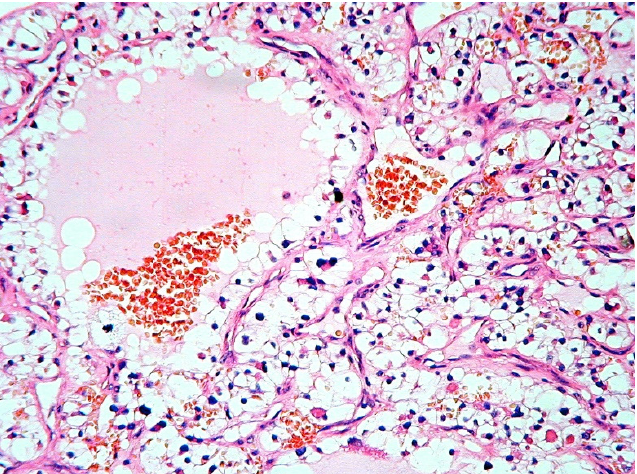
Figure 3. Morphologic features of classic clear cell renal cell carcinoma: the tumor cells are aggregated in solid clusters or in follicular-like structures and show extensive cytoplasmic clearing. Also, clusters of red blood cells and capillary vessels are easily detected among tumor cells. (Hematoxylin-eosin, original magnification ×200).